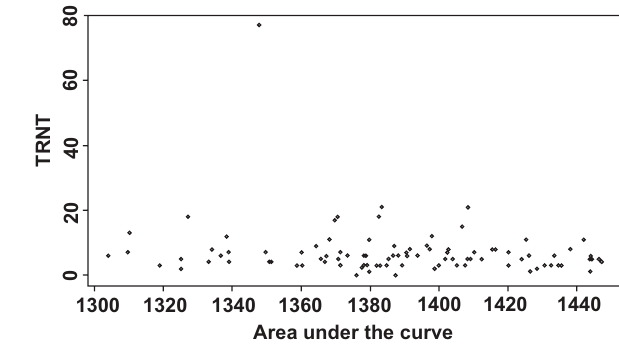
Figure 12. Time to removal of nasogastric tube (TRNT) (days) versus area under the curve ( ° C*minutes). Scatterplot showing the relation between TRNT and AUC.